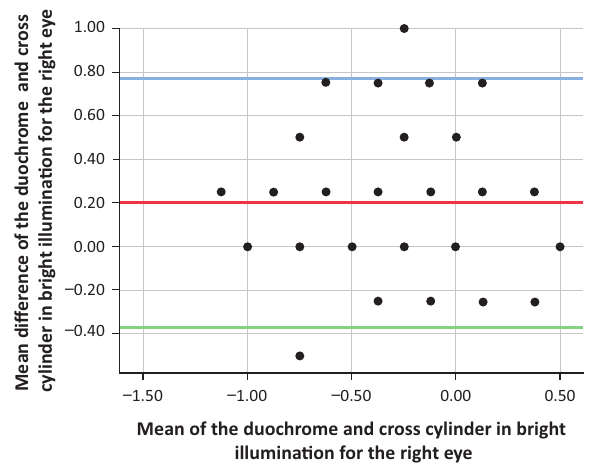
FIGURE 2: Plot of the means and differences ( D ) between the duochrome and unfused cross cylinder tests in bright room illumination. The horizontal solid line represents the mean of the difference. The area between the two outer horizontal lines represents the 95 % limits of agreement between the two methods.